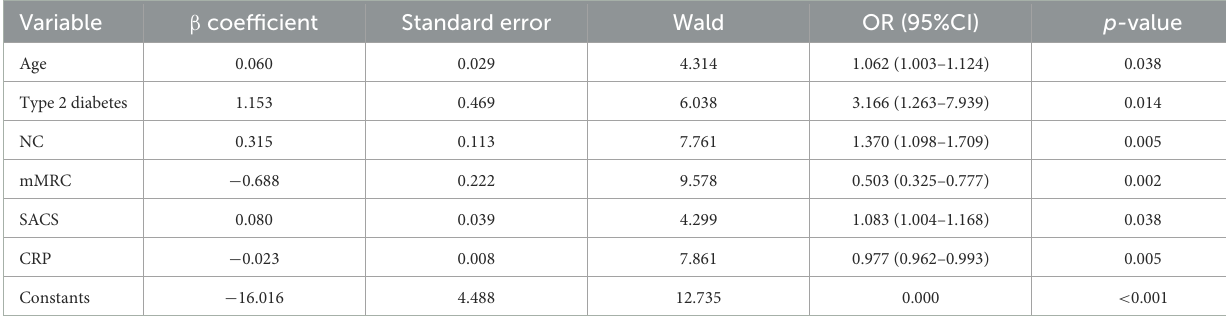
TABLE 3 Multivariate logistic regression analysis in train group.